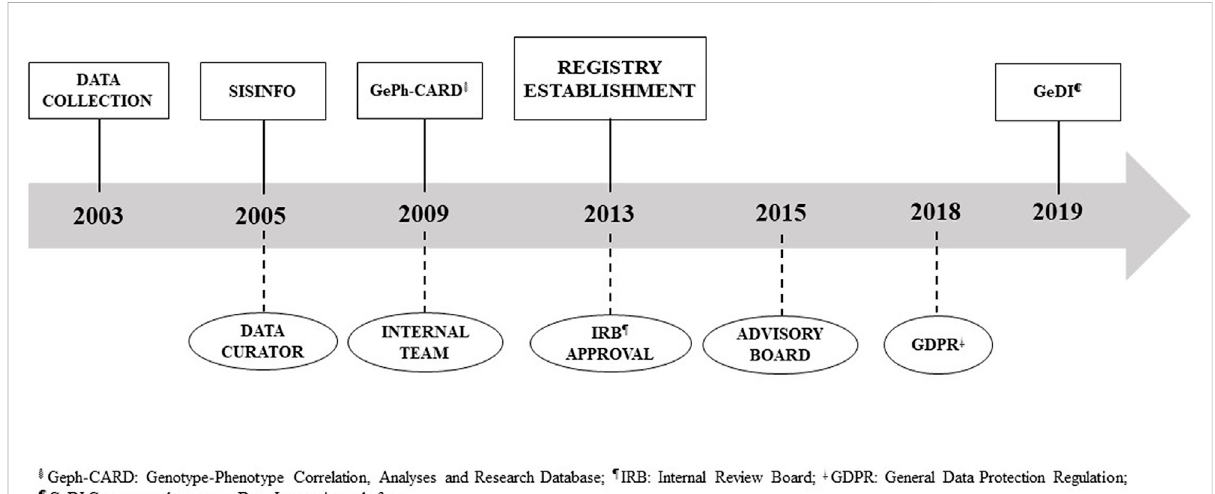
FIGURE 1 REM registry